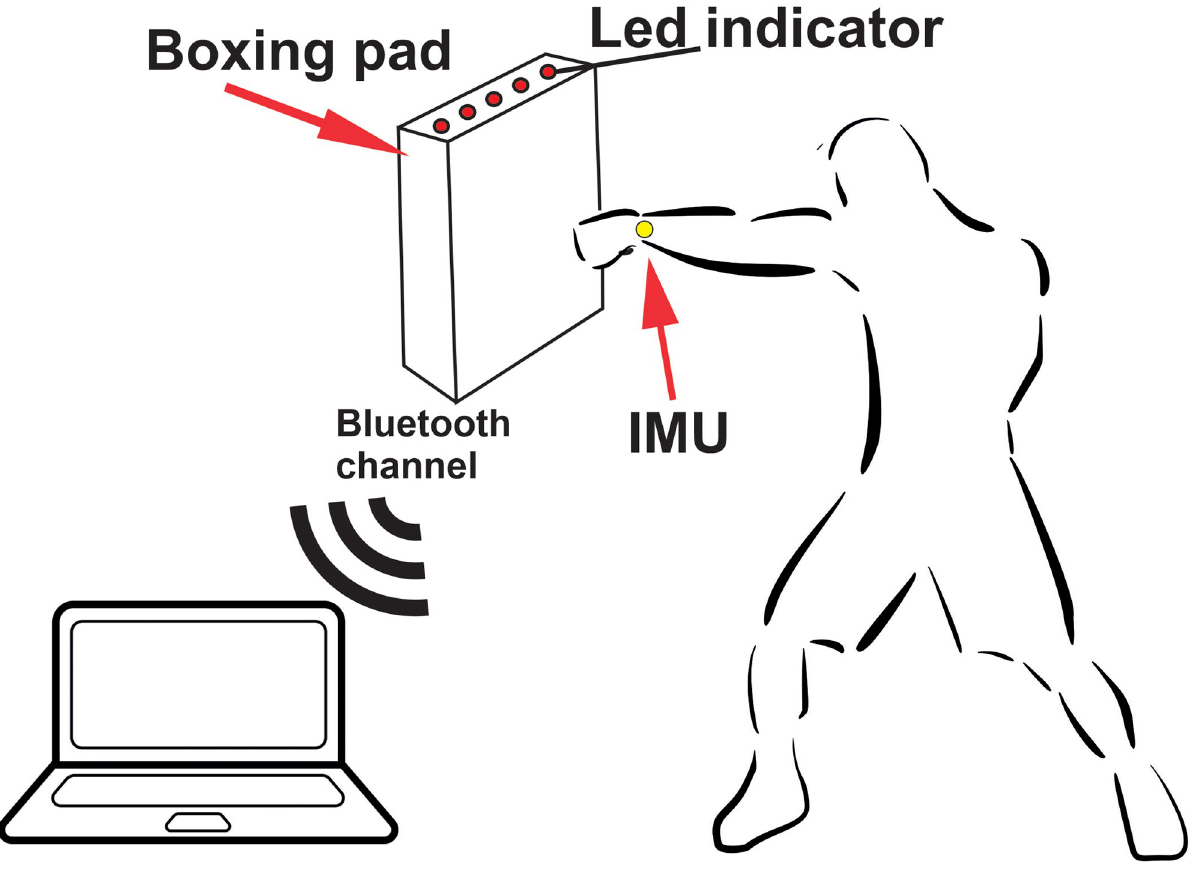
Fig 1. Design of